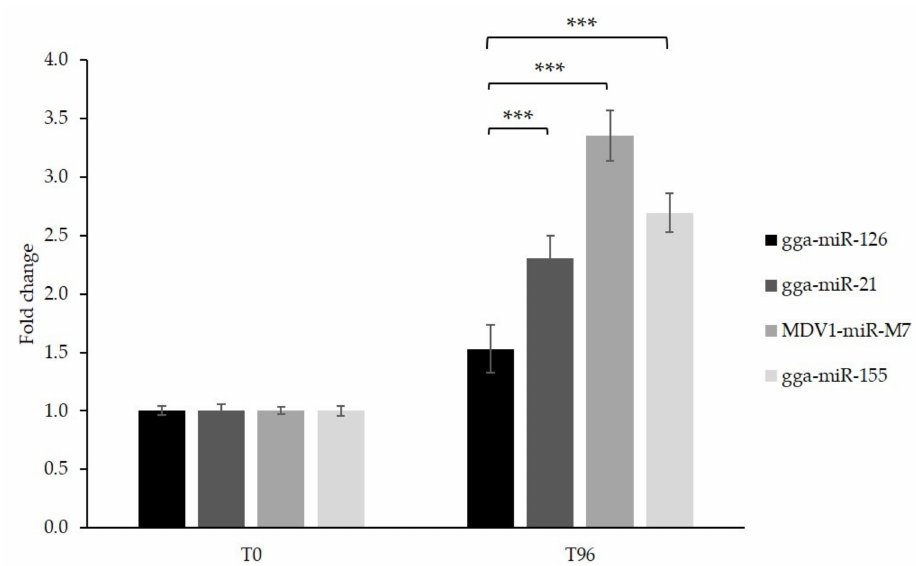
Figure 6. Cell proliferation after tetracycline induction at two time points. Cell proliferation evaluation by MTS assay, before (T0) and 96 h (T96) after induction of the expression of miR-126 and control miRNAs in stable MSB-1 cell lines containing the respective plasmids, presented as the mean fold change (three independent assays with technical triplicates) in cell viability between the two time points. Student t -test: ***, p < 0.001 represent significant results. Error bars are standard deviations of